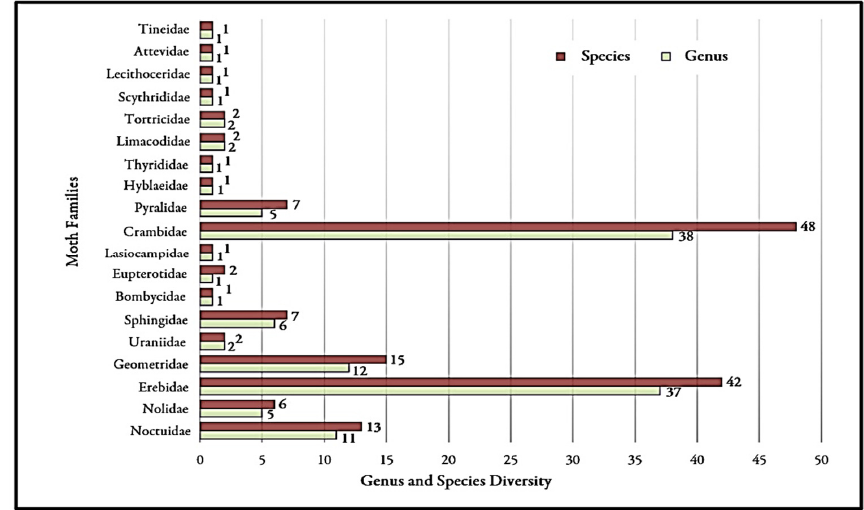
FigFigFigFigure 4. ure 4. ure 4. ure 4. Graph denoting genus and species diversity in observed moth